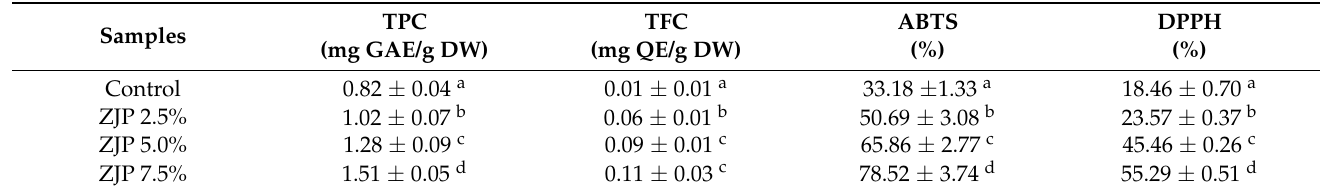
Table 2. Total phenolic content (TPC), total flavonoid content (TFC), and radical scavenging activity of pizza base enriched with ZJP, tested by ABTS • + and DPPH •